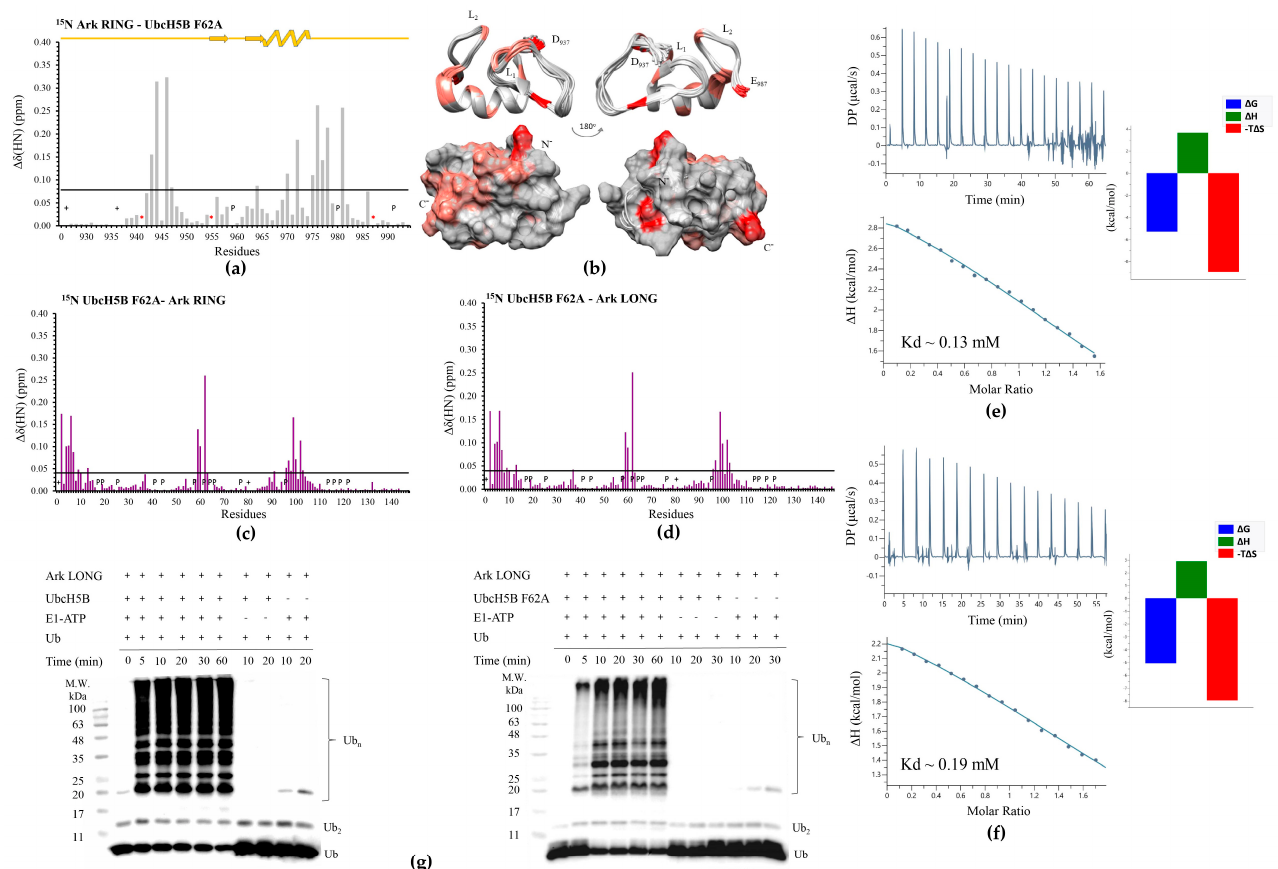
Figure 2. Interaction of E3 Arkadia with the E2 UbcH5B F62A mutant. ( a ) Diagram of the total CSPs measured at a 1:2 molar ratio (saturation point) for 15 N Ark RING/ 14 N UbcH5B F62A, *: represents disappeared residues, +: represents residues with no information. ( b ) Ark RING mapping (PDBid: 2KIZ) after addition of UbcH5B F62A (residues that disappeared during the interaction are colored red, whereas residues that exhibited ‘fast exchange’ interactions are colored coral). ( c ) Diagram of the total CSPs measured at a 1:2 molar ratio for 15 N UbcH5B F62A/ 14 N Ark RING. ( d ) Diagram of the total CSPs measured at a 1:2 M ratio for 15 N UbcH5B F62A/ 14 N Ark LONG. ( e ) ITC data for the titration of UbcH5B F62A into Ark RING and ( f ) into Ark LONG. ( g ) In vitro auto-ubiquitylation assays of Ark LONG using UbcH5B F62A ( right ) and wt UbcH5B ( left ). Table 1. Thermodynamic parameters of the Arkadia constructs and mutants’ interaction with the E2 enzymes and their mutants obtained by ITC at 25 ◦ C.